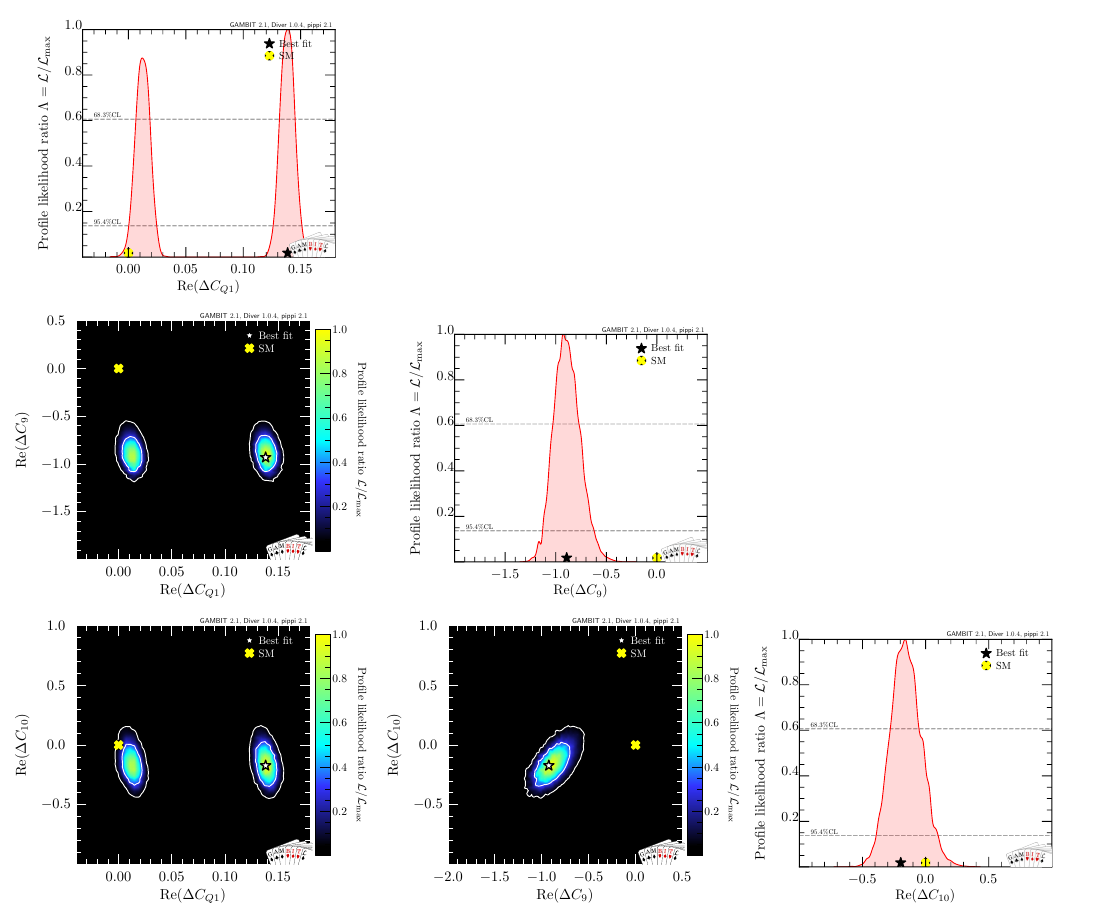
Figure 9 . One- and two-dimensional profile likelihoods for three of the Wilson coefficients computed from the